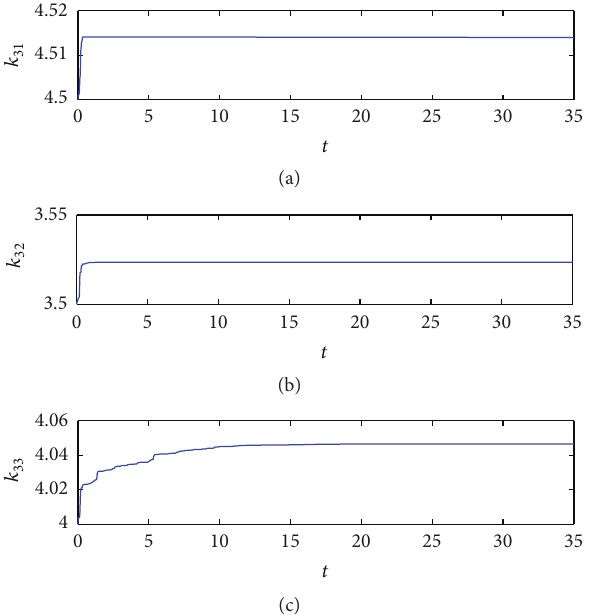
Figure 13: Time responses of error system under control input in Example